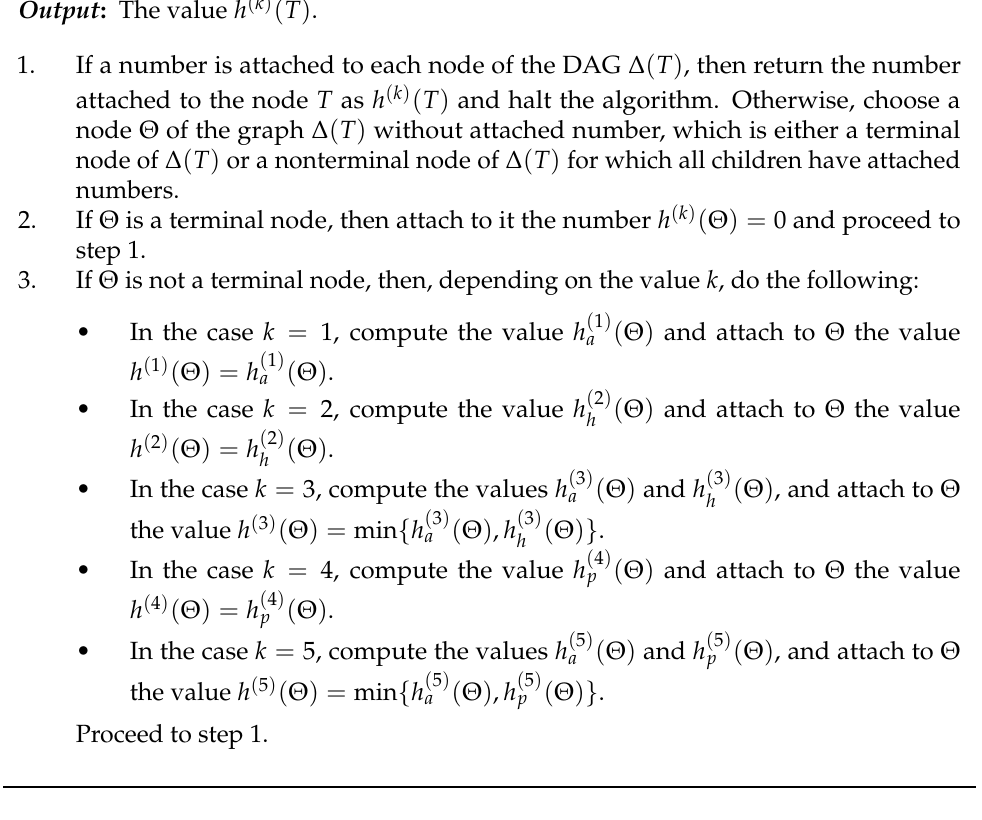
Algorithm A h (computation of h ( k ) ( T )